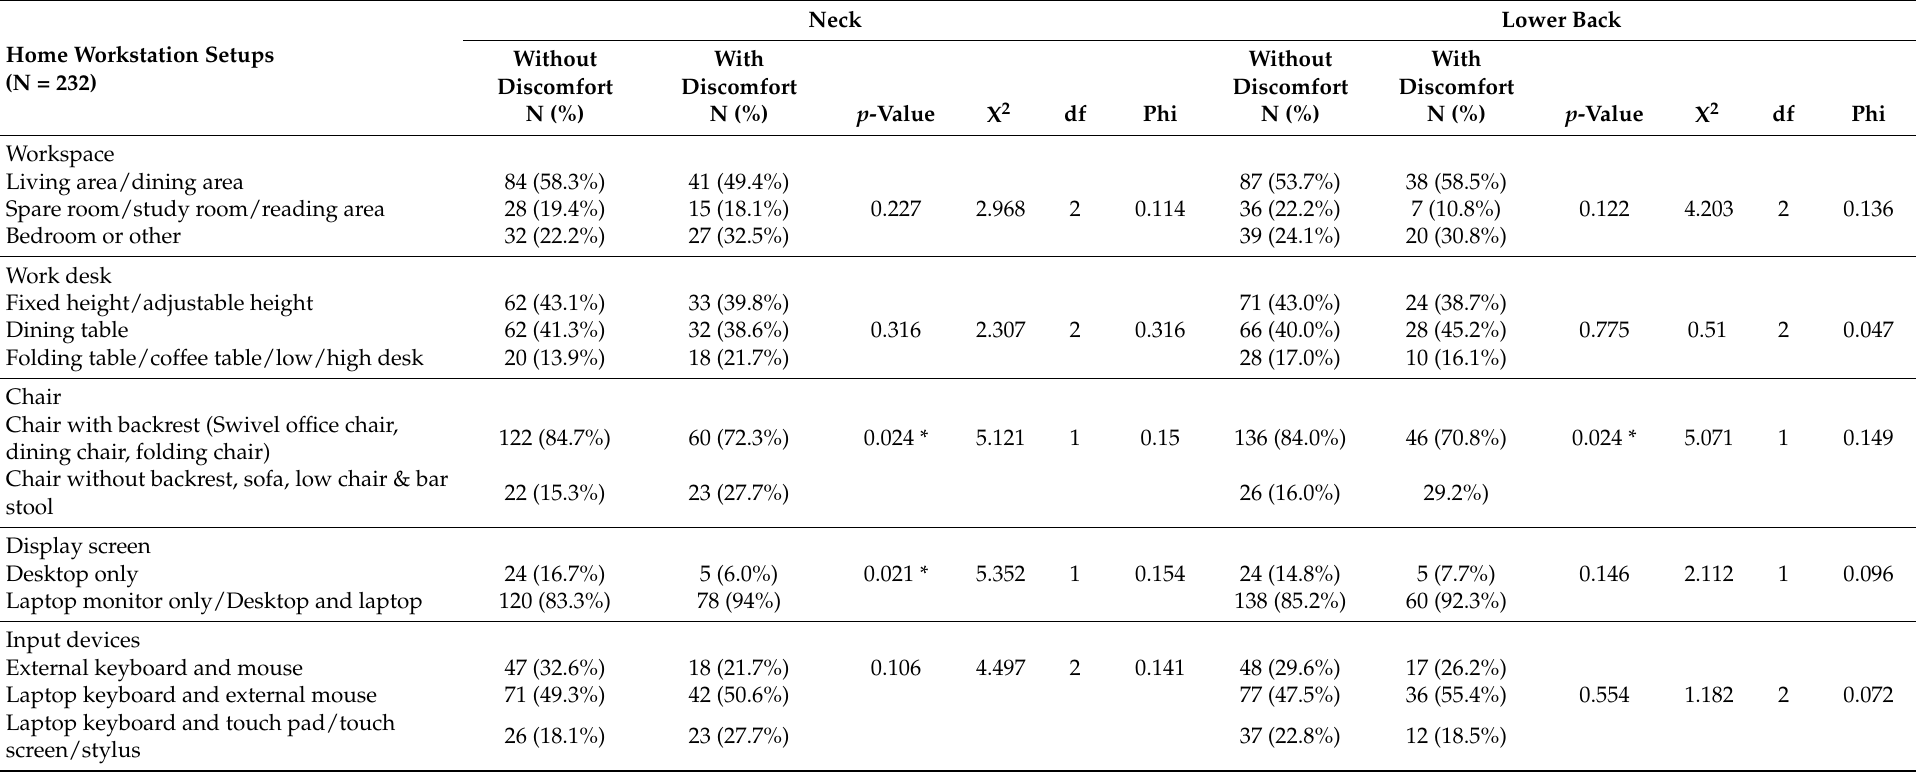
Table A7. The association between the home workstation setups and with/without neck, lower back, upper back, and right shoulder discomfort.